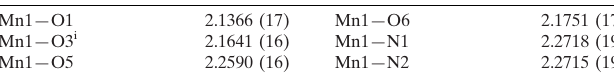
Selected bond lengths (A˚ ).